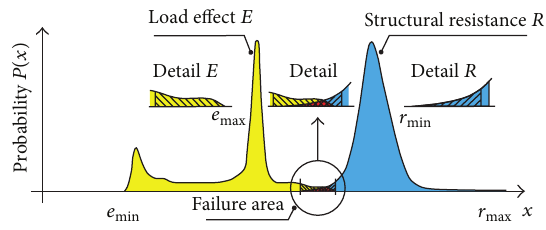
Figure 2: Probability density curves—load effect, 𝐸 , structural resistance, 𝑅 , and the area where a failure may occur.